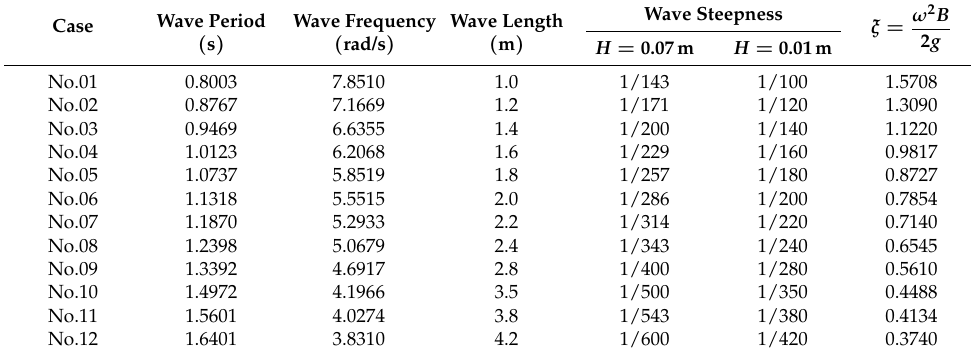
Table 2. Numerical parameters of twelve cases for simulation of wave-structure interaction of a surface-piercing